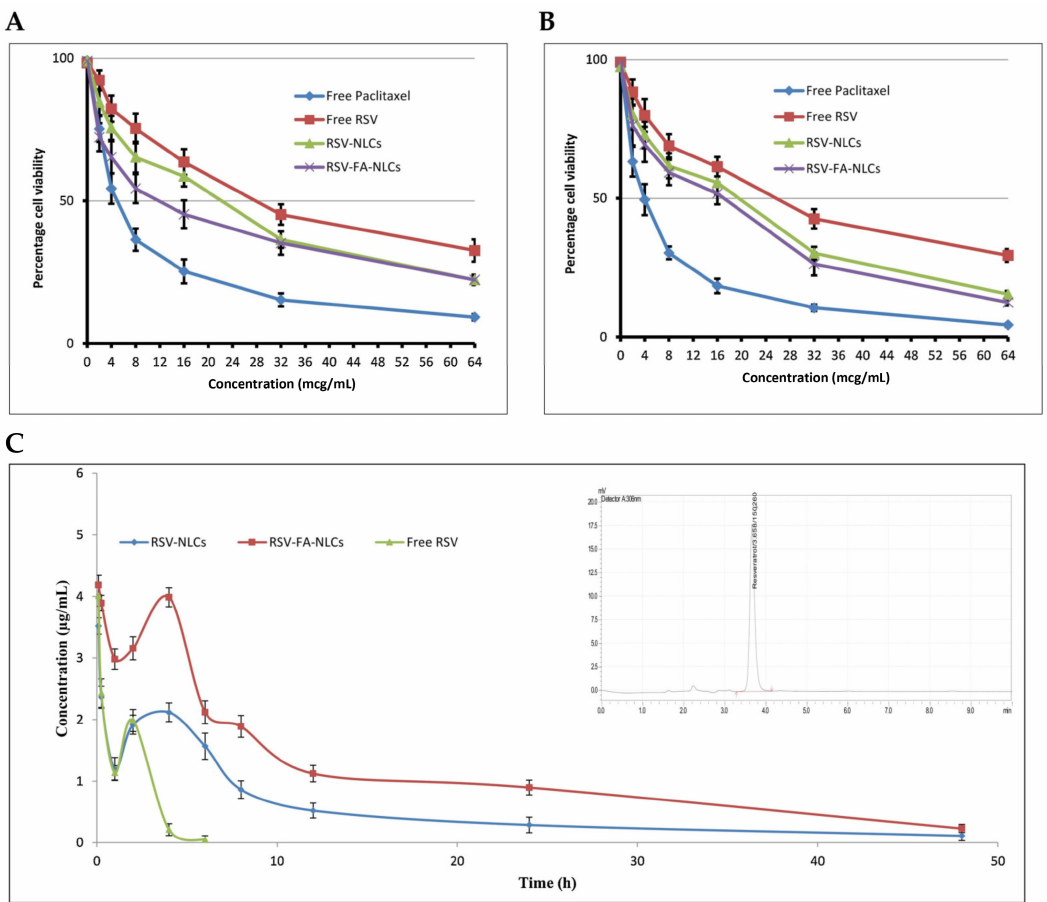
Figure 3. The in vitro cell viability of ( A ) MCF-7 and ( B ) A549 cells at various drug concentrations of the drug after 72 h treatment. ( C ) Plasma concentration–time profile of resveratrol (RSV) in rats with intravenously administered free RSV, RSV-NLCs and RSV-FA-NLCs; inset shows representative HPLC chromatogram of RSV in rat plasma. Source: reprinted from Poonia, N.; Kaur Narang, J.; Lather, V.; Beg, S.; Sharma, T.; Singh, B.; Pandita, D., Resveratrol loaded functionalized nanostructured lipid carriers for breast cancer targeting: Systematic development, characterization and pharmacoki- netic evaluation. Colloids and Surfaces B: Biointerfaces 2019, 181, 756–766 [53]. With permission from